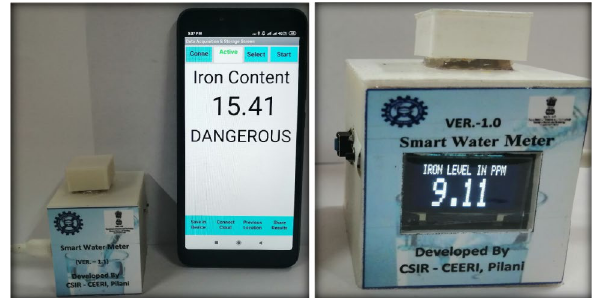
Fig. 6 Developed handheld IoT-enabled and standalone spectrometer system for offline heavy metal